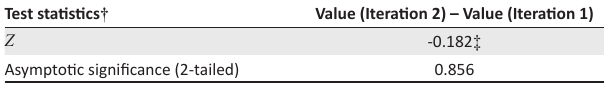
TABLE 4 : Test statistics for the value sub-scale.